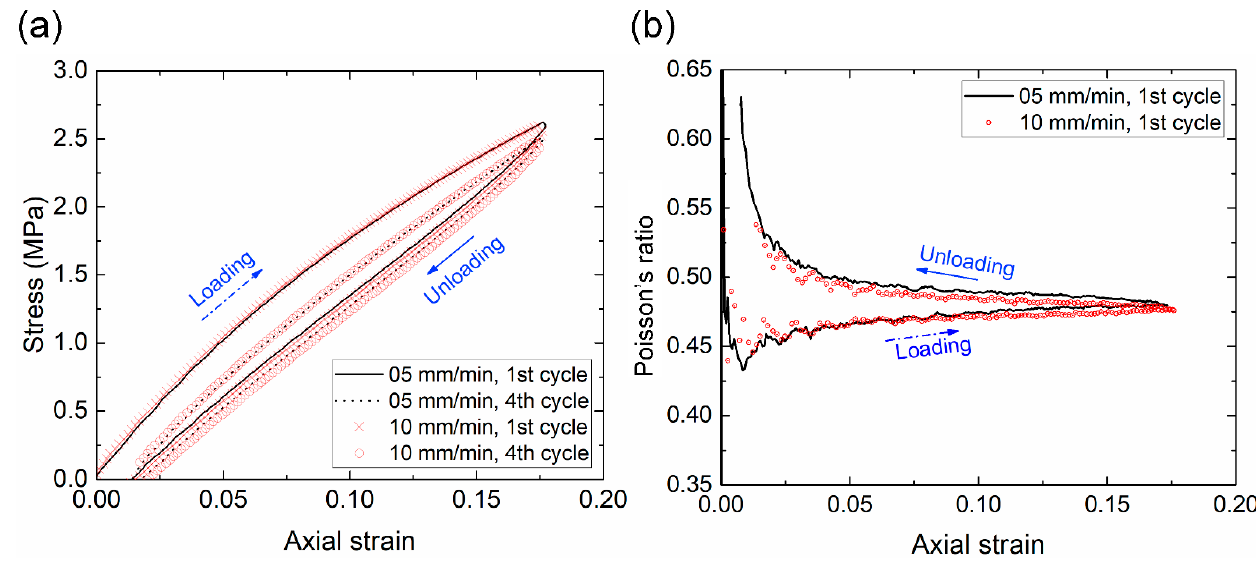
Figure 6. ( a ) The equilibrium stress-strain curves at the first and fourth cycles at loading rates of 5 mm/min and 10 mm/min. ( b ) Effect of the loading rate on the Poisson’s ratio (Hencky form) at the first cycle.